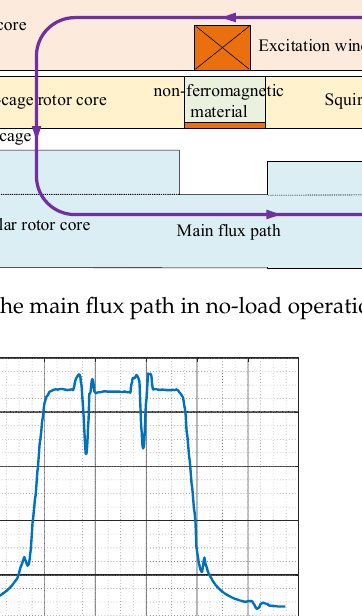
Figure 5. Air gap flux density distributions at different positions of the HTR-ASD.